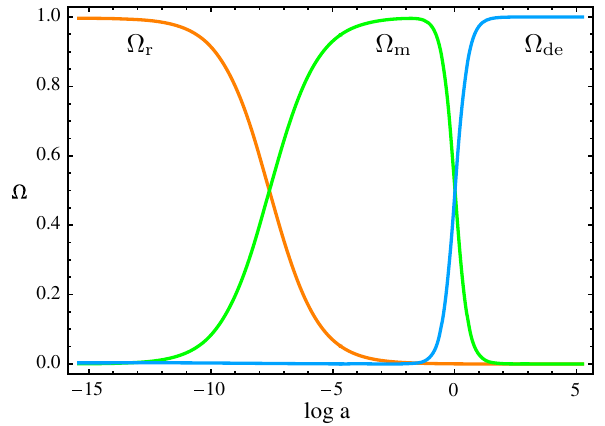
Fig. 3 We plot the dimensionless energy density ratio (cid:9) r ,(cid:9) m and (cid:9) de vs log a . All the salient features of Fig. 2 are clearly evident